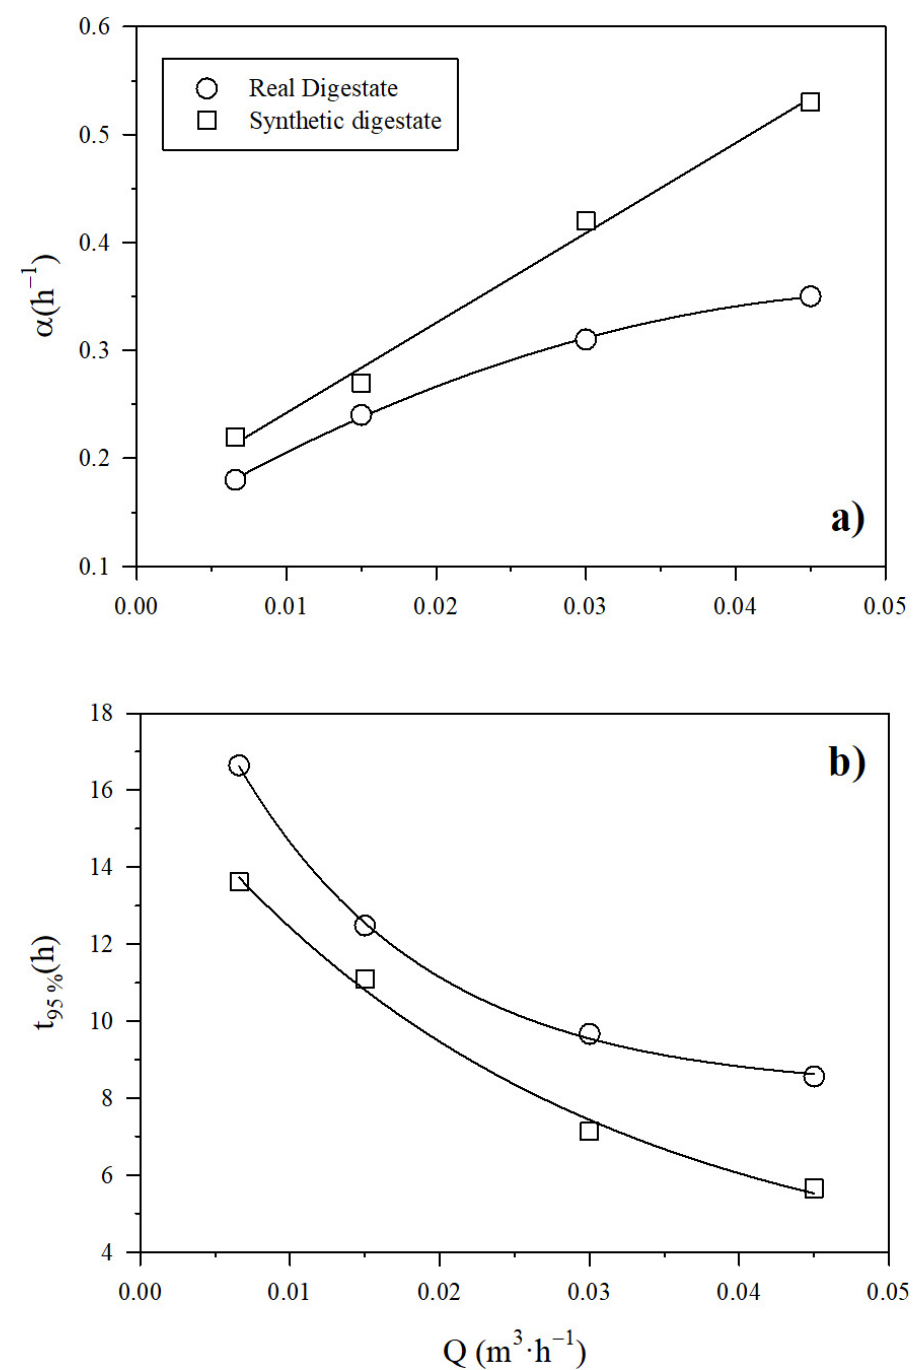
Figure 4. Influence of the recirculation flow rate on ( a ) α , and ( b ) the time to reach 95% NH 3 recovery using a PTFE-0.22 membrane at different recirculation flow rates at a pH of 10 and a concentration of H 2 SO 4 of 1M for both digestates.